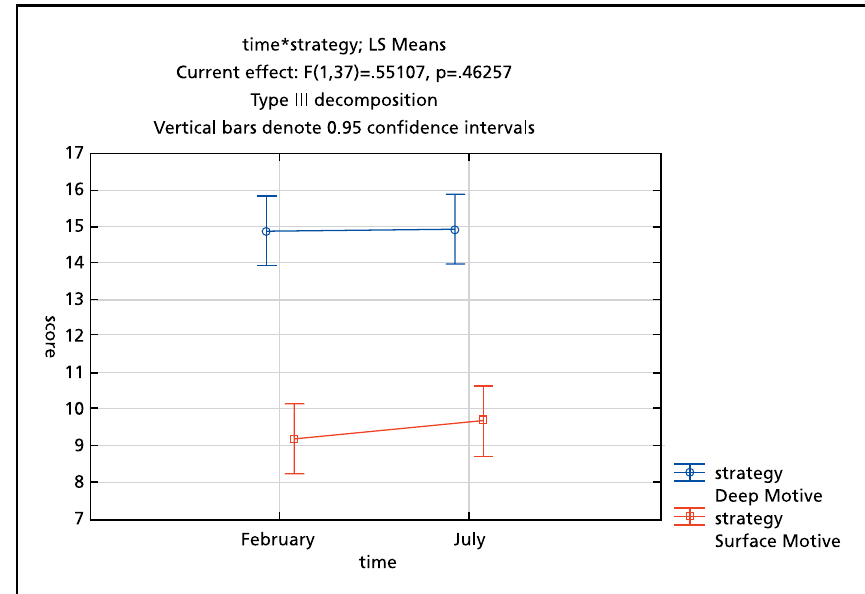
Figure 3 Deep versus surface motives over